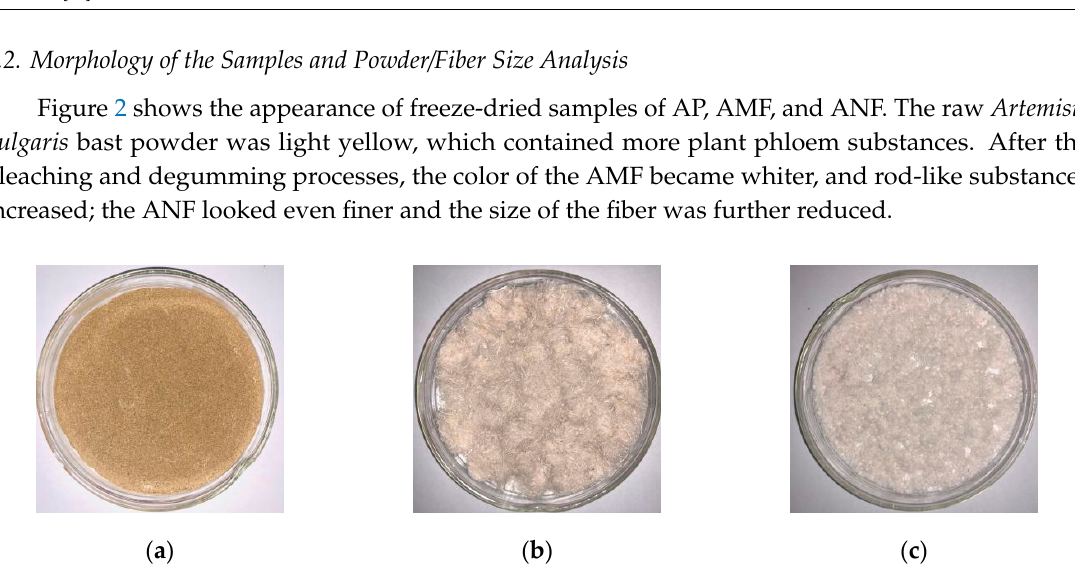
Figure 2. Photographs of ( a ) raw Artemisia vulgaris bast powder; ( b ) Artemisia vulgaris bast microcellulose fibers; ( c ) freeze-dried powders of nanocellulose fibers.